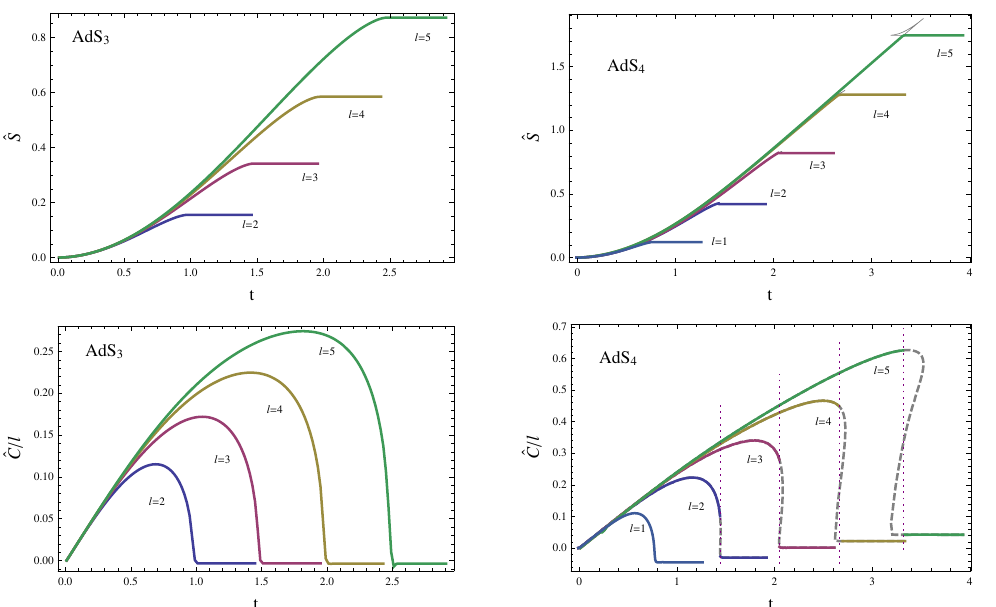
Figure 8 . The upper panels show the evolution of the entanglement entropy for di(cid:11)erent l . The lower panels show the corresponding subregion complexity density ^ C=l (thick lines) for di(cid:11)erent l . We (cid:12)x M = 1 ; v 0 = 0 : 01 here.